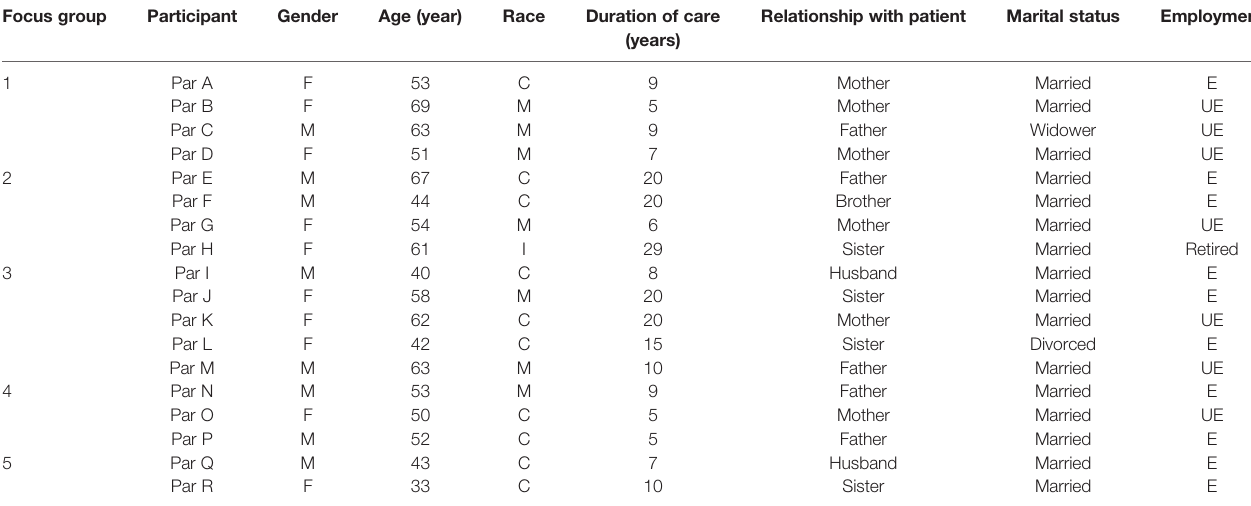
TABLE 2 | Socio-demographic data of participants (n =